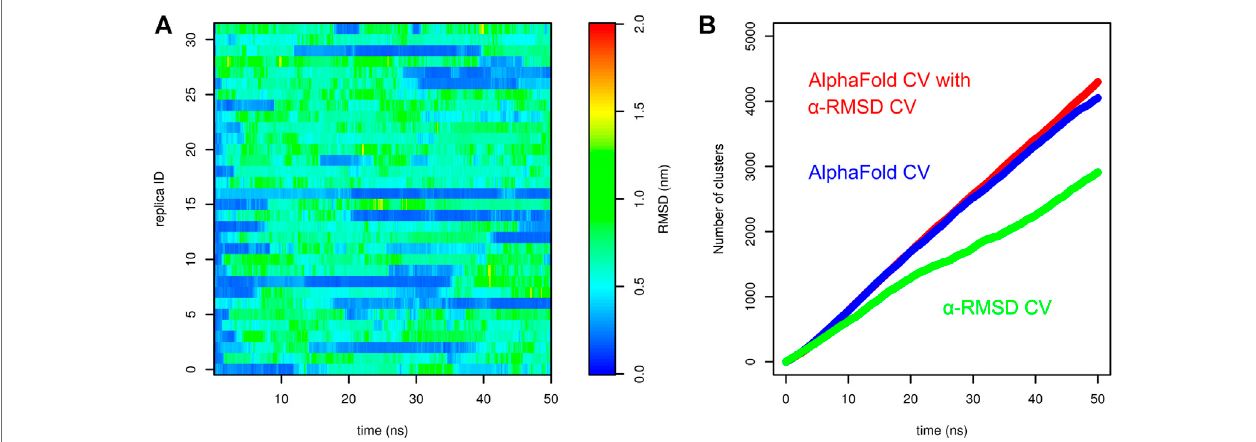
FIGURE 7 | Comparison of parallel tempering metadynamics simulation of Trp-cage with α -RMSD CV with other CVs. (A) Pro fi les of RMSD in parallel tempering metadynamics with α -RMSD CV as a function of time calculated for demultiplexed trajectories and (B) comparison of the cumulative number of conformational clusters explored by parallel tempering metadynamics with different